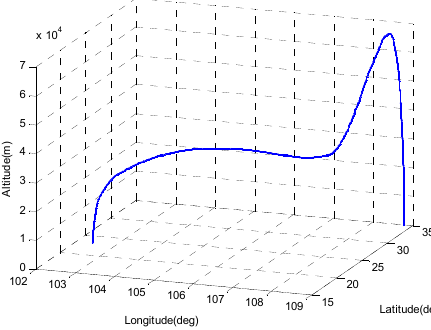
Figure 8. Simulated flight profile of a hypersonic vehicle.